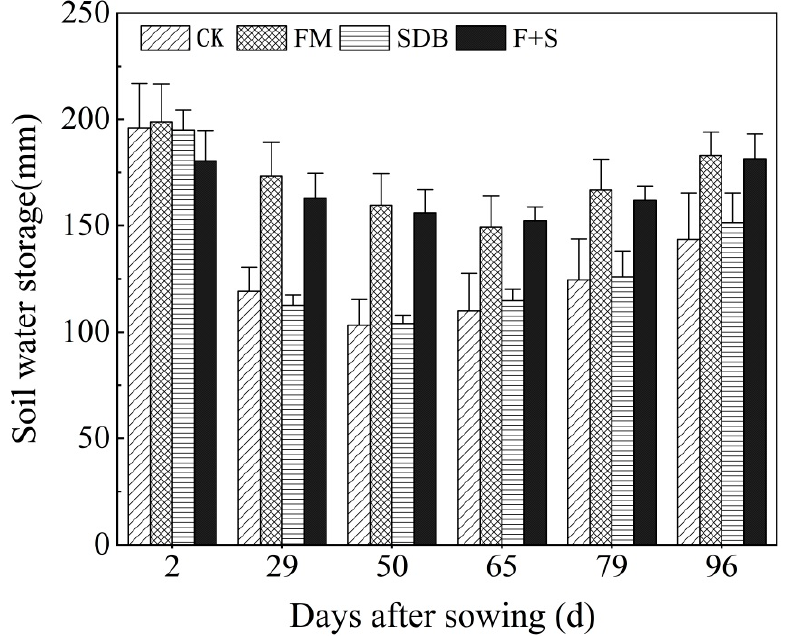
Figure 1. The soil water storage under each treatment with days after sowing.